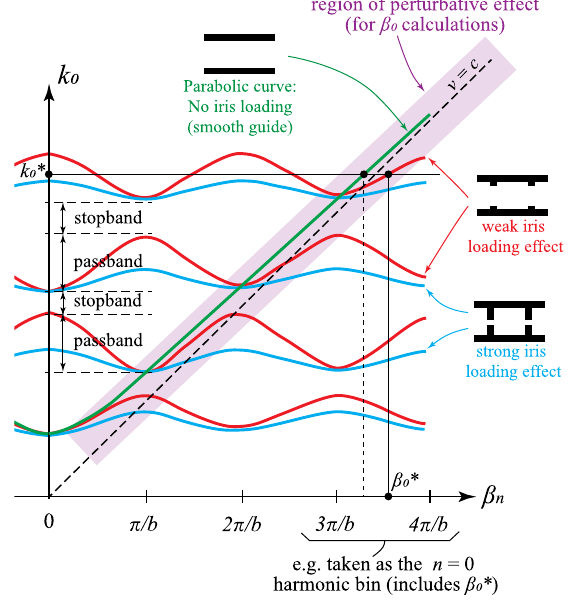
5. A qualitative sketch demonstrating the effect of iris loading on an otherwise-smooth pipe as the depth of iris loading (added admittance) is changed. In this sketch β n is assumed to be real (no loss). For a smooth pipe, the continuous parabola (green) is observed, where phase velocity v ≥ c and k 0 ≥ β 0 for propagating modes, asymptotically leading to the limit of TEM propagation at the 45-deg line. As we start loading the pipe with shallow (weak) irises, the propagated modes are allowed in certain passbands, attenuated in stop bands, and the dispersion curves (red) become periodic in β n , with every side lobe period (index n ) now corresponding to a Fourier harmonic bin, where β n ¼ β þ 2 π n=b . This allows for slow and fast waves to propagate 0 (depending on the used harmonic). If the irises are gradually removed, the passband curves (red) expand and coalesce back into the parabolic curves of the smooth pipe (green) [20]. If the iris loading increases, the passbands (blue) are compressed, and in the limit they become flat spectral lines, with wider stop bands in between. Since our structure is highly overmoded with a paraxial incidence, we effectively operate in the perturbation region (purple shade) in the vicinity of the parabolic curve and make our choice for the n ¼ 0 harmonic band accordingly; see the simplified example of point ð β (cid:4) 0 ; k (cid:4) 0 Þ on the